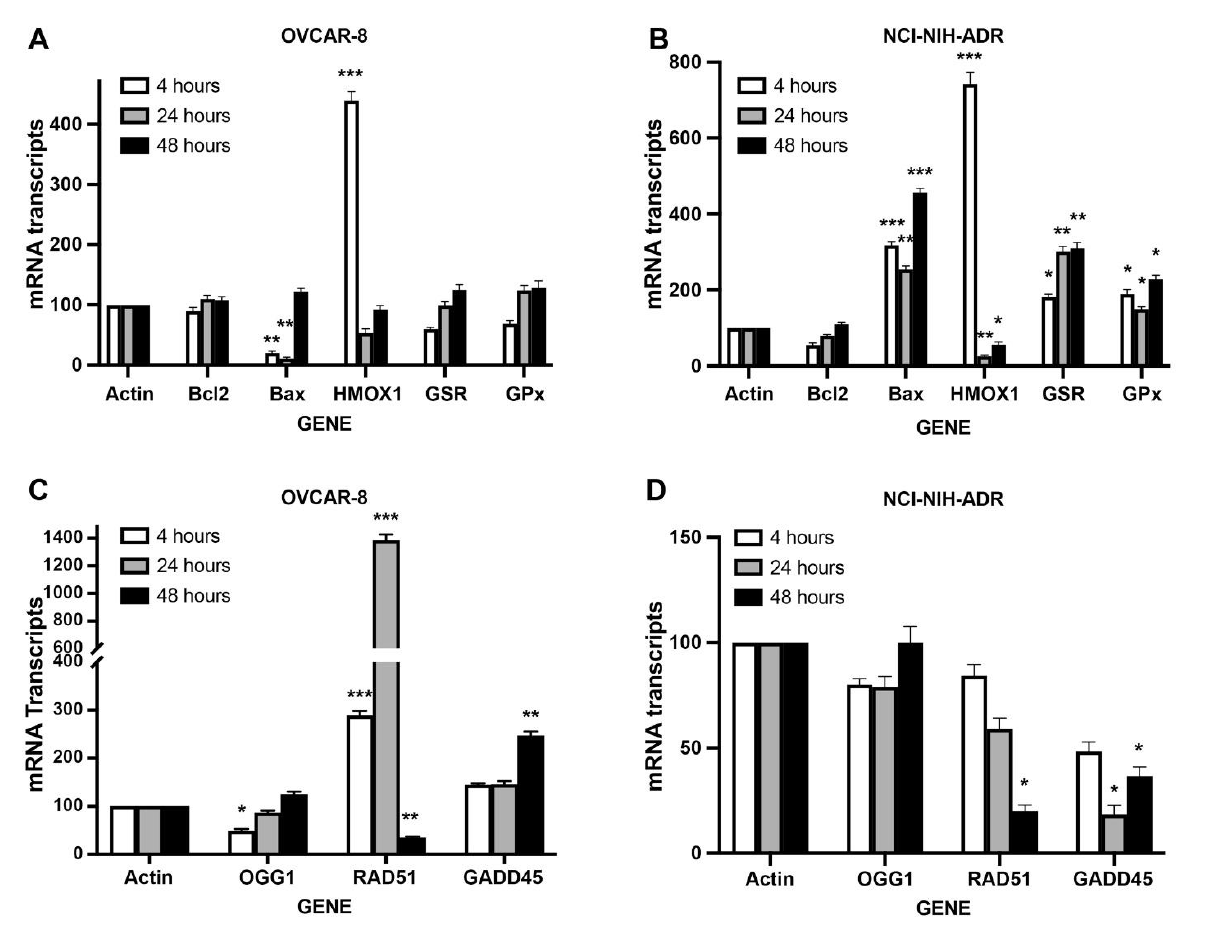
Figure 9. RT-PCR analysis of apoptosis- and oxidative stress-related genes differentially expressed by NCX4040 (5 µM) in OVCAR-8 ( A ) and NCI/ADR-RES ( B ) cells and DNA damage and DNA repair genes in OVCAR-8 ( C ) and NCI/ADR-RES ( D ) following 4, 24 and 48 h NCX4040 treatment. RT-PCR was carried out as described in the methods section. *, ** and *** p -values, <0.05, <0.005 and <0.001, respectively, compared to actin controls.